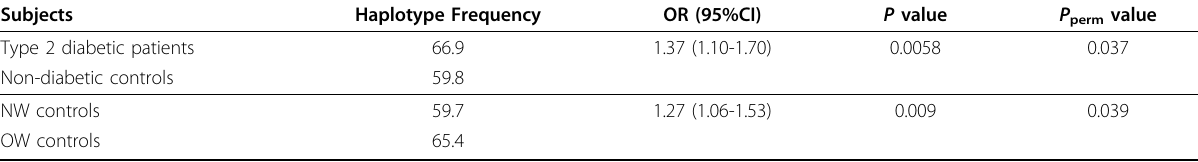
Table 3 Association of haplotype GGC with type 2 diabetes and obesity in North Indian population